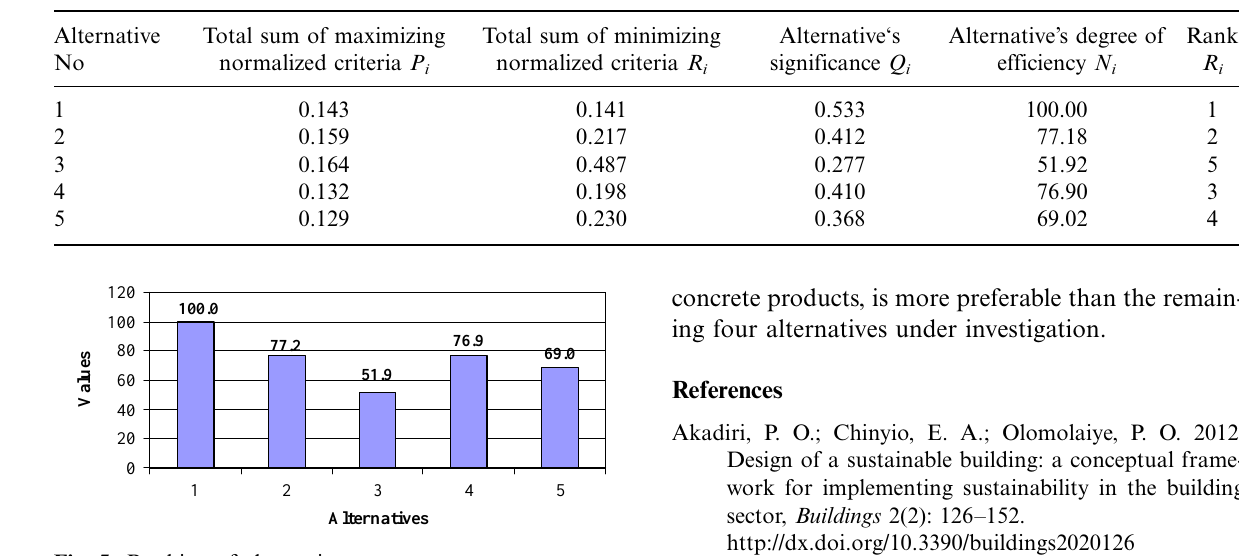
Table 4. Calculation results